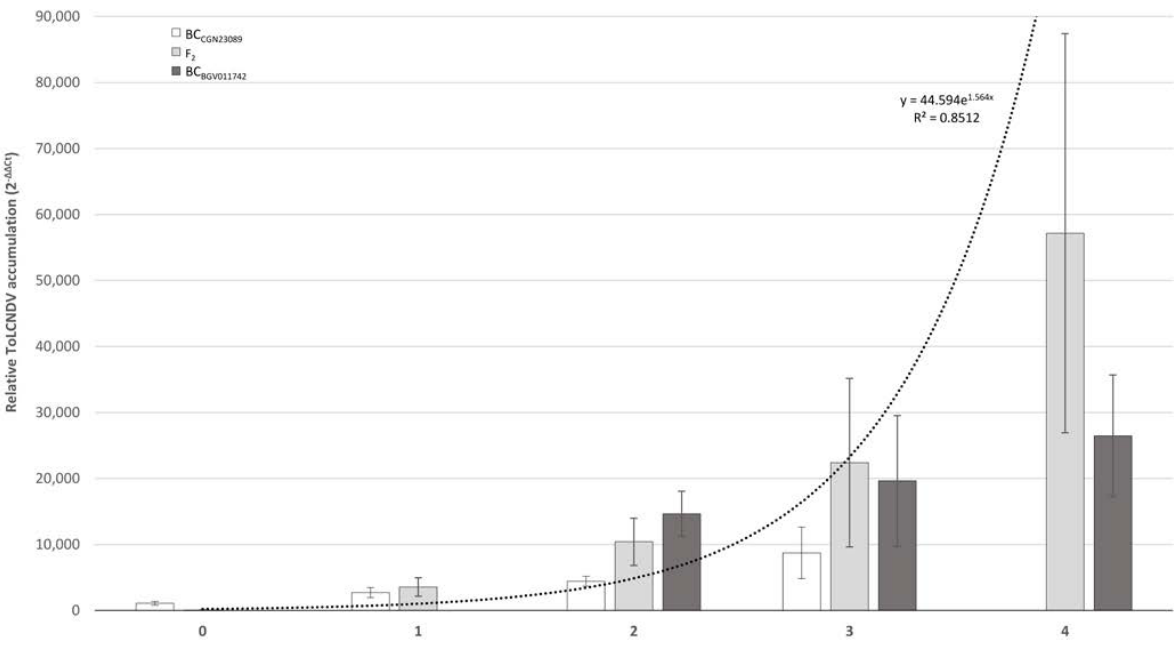
Figure 4. Mean of relative viral accumulation (2 − ∆∆ Ct ) at 30 days after mechanical inoculation in plants of F 2 (CGN23089-2 x BGV011742) (light gray bars), BC CGN23089 (white bars), and BC BGV011742 (dark gray bars) in each symptom score category. Dotted line shows the tendency of the variable adjusted to an exponential